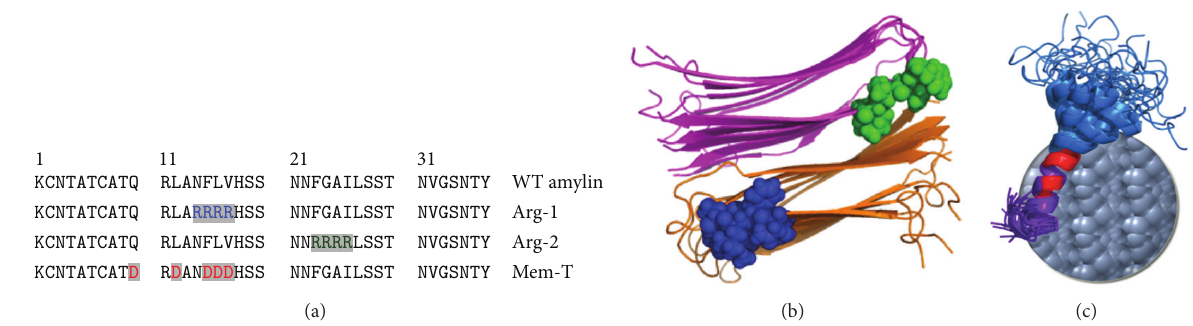
Figure 1: Design of fibrillization inhibitors. (a) Sequences of WT amylin and the three peptide analogs that incorporate strings of positive or negative charges in the amylin sequence. (b) Model of the stacked 𝛽 -hairpin structure of amylin fibrils based on ssNMR [13]. Positively charged arginine residues are shown as spheres that are positioned at the end of strand 𝛽 1 in Arg-1 (blue) or at the start of strand 𝛽 2 in Arg-2 (green). (c) Solution NMR model of micelle-bound amylin, in which the N-terminal residues 5–17 are embedded in the hydrophobic environment of the micelle [16]. The Mem-T peptide substitutes hydrophobic residues in this region for five aspartates (red), in order to interfere with membrane binding through electrostatic repulsion between negatively charged residues on the peptide and lipid head-groups.